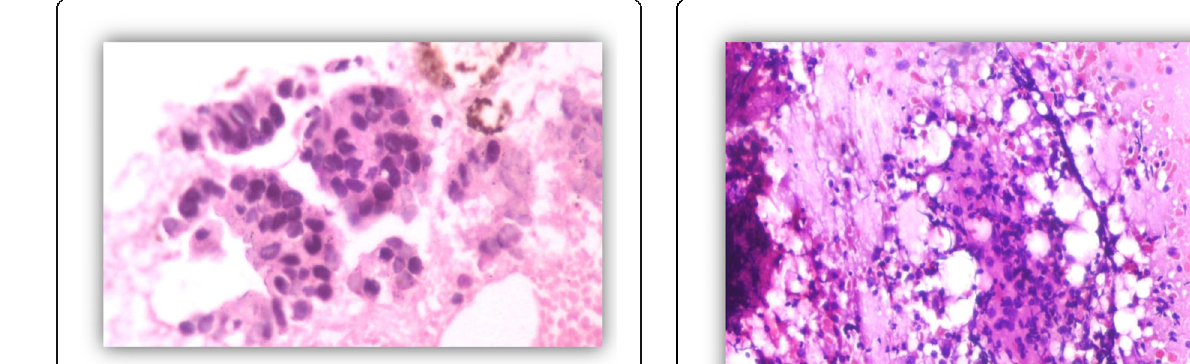
Fig. 4 Imprint cytology for metastatic adenocarcinoma of the pleura